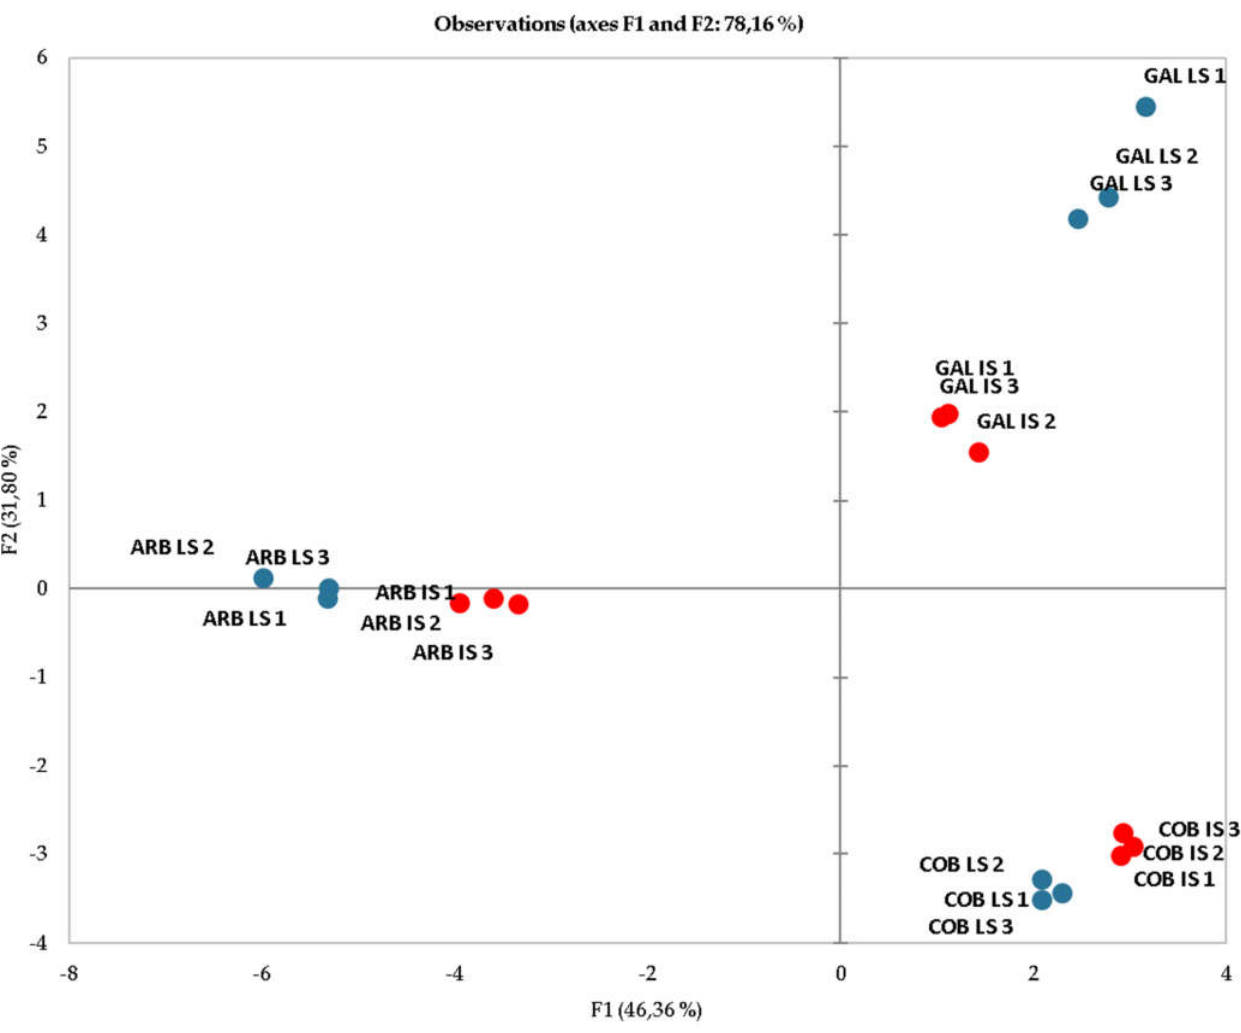
Figure 2. Principal component analysis (PCA) of the fatty acid characterization of olive oils (OO) obtained by two different extraction methods, laboratory scale (LS) and industrial scale (IS), analyzed in triplicate for three cultivars: GV ‘Galega vulgar’, COB ‘Cobrançosa’ and ARB